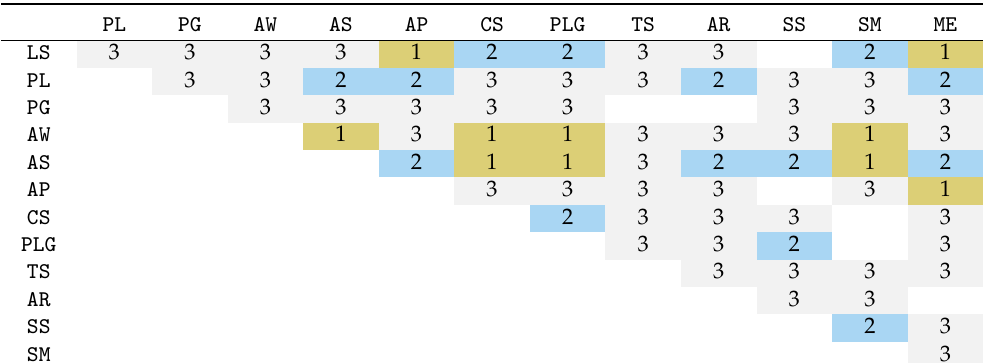
Table 3. Results of interaction public area × time of day.